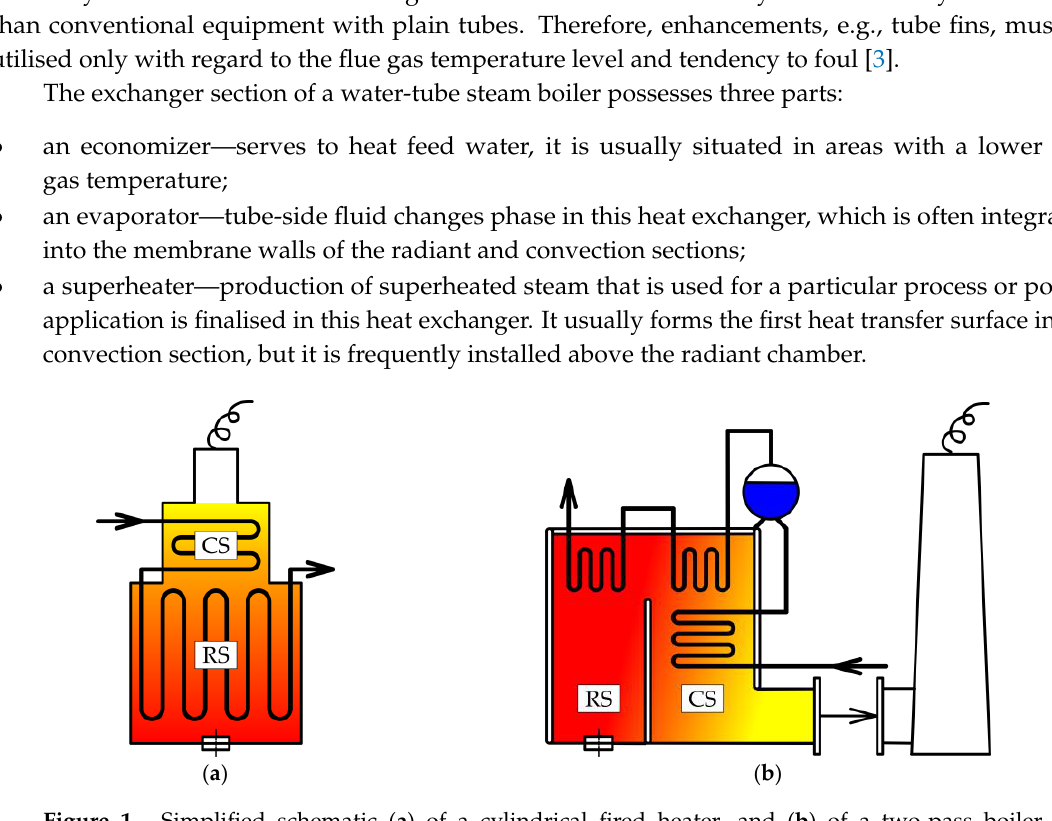
Figure 1. Simplified schematic ( a ) of a cylindrical fired heater, and ( b ) of a two-pass boiler. Abbreviations CS and RS stand for convection and radiant sections, respectively.